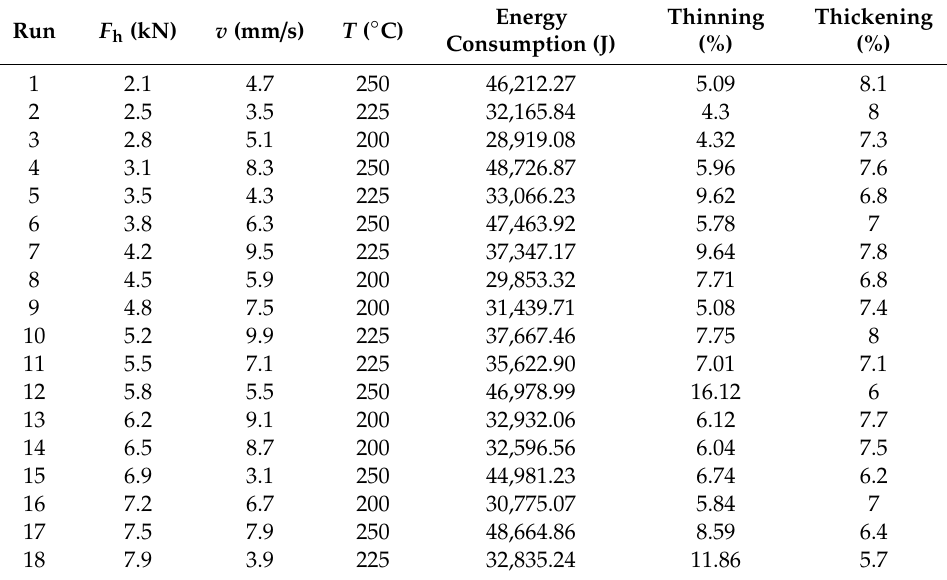
Figure 9. Numerical simulation model of the tube-shaped part. Table 3. Experimental design points and corresponding